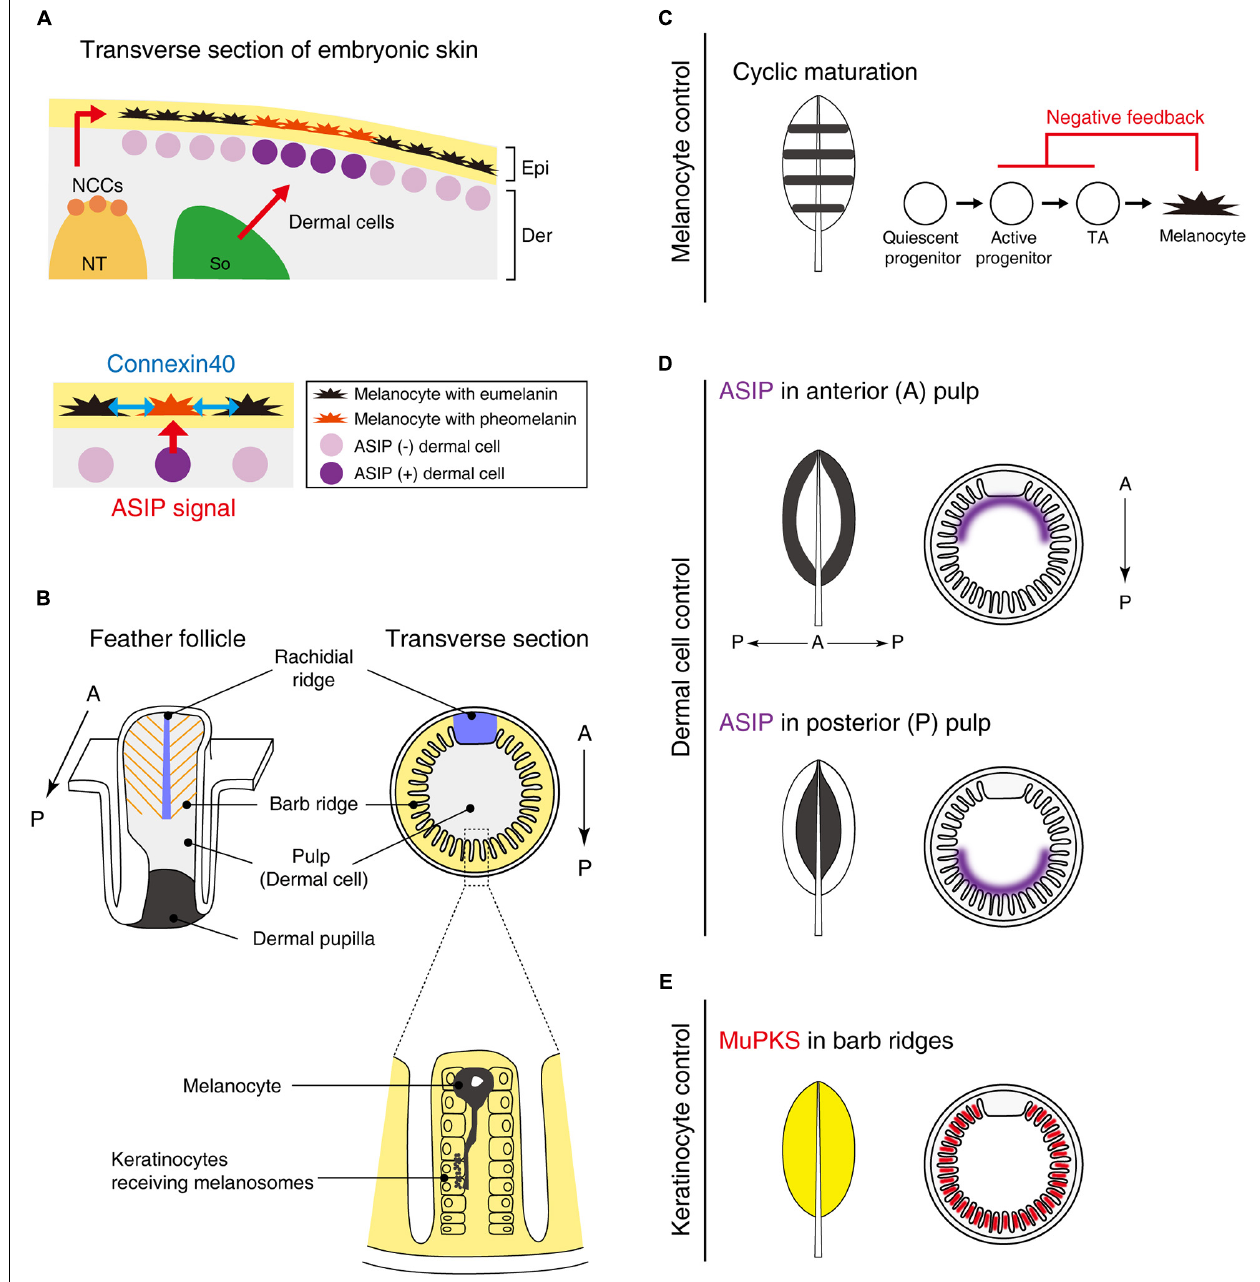
FIGURE 2 | Putative molecular mechanisms in macro- and micro-pigment pattern formation. (A) The embryonic development of Japanese quail skin (Left). Neural crest cells (NCCs) delaminate from the dorsal part of the neural tube (NT). Some NCCs differentiate into melanoblasts and emigrate to their destination in the epidermis (Epi). A part of the somite (So) differentiates to dermis (Der). Dermal cells in the vicinity of melanocytes secrete ASIP to switch the melanin synthesis pathway from eumelanin to pheomelanin. Dermal cell–melanocyte interactions confer striped pigment patterns (Lower) (Haupaix et al., 2018). In addition, melanocytes interact with each other via connexin40 (blue arrows) to refine the size of the pigmentation stripes (Inaba et al., 2019b). (B) Schematic drawing of a feather follicle. Melanocytes are located within barb ridges and transport its melanosome into adjacent keratinocytes (Lin et al., 2013). (C–E) Schematic drawing showing that interactions between melanocytes and their environments (dermis/epidermis) form a variety of feather pigment patterns. (C) Melanocyte intrinsic banded pigment pattern. Cyclic maturation of the progenitor cells gives rise to banded pigment patterns on the feather vane. To accomplish this oscillation, negative feedback from mature melanocytes to active progenitors and transit amplifying cells (TA) is assumed. (D) Dermal cell instructive pigment pattern. ASIP is expressed in either side of the anterior or posterior pulp comprised of dermal cells, leading edge, or central pigmented patterns (Lin et al., 2013). (E) Feather keratinocytes can confer the pigmentation. MuPKS, polyketide synthase, is expressed in barb ridges and deposits yellow psittacofulvin pigments (Cooke et al., 2017).